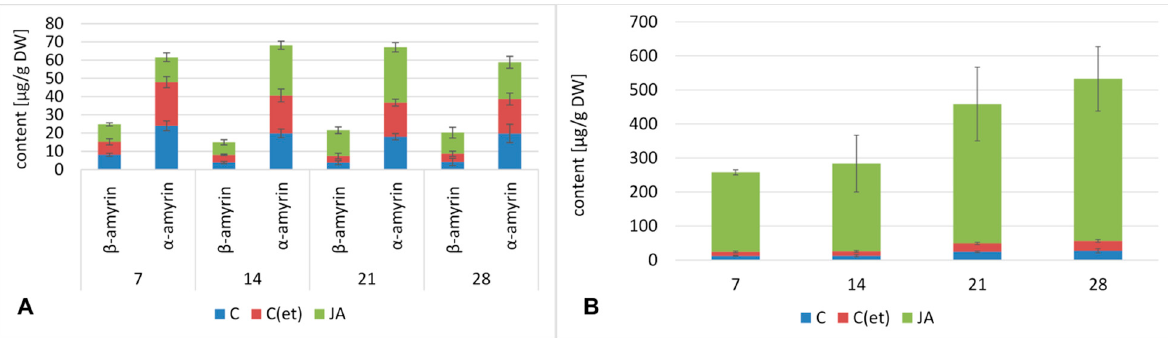
Figure 6. The effect of jasmonic acid on the content of neutral triterpenoids (amyrins) ( A ) and free oleanolic acid ( B ) in hairy roots tissue. C—control, C(et)—control samples supplemented with 70% ethanol, JA—jasmonic acid-elicited samples. See detailed data and statistical significance in Tables S7 and S9.